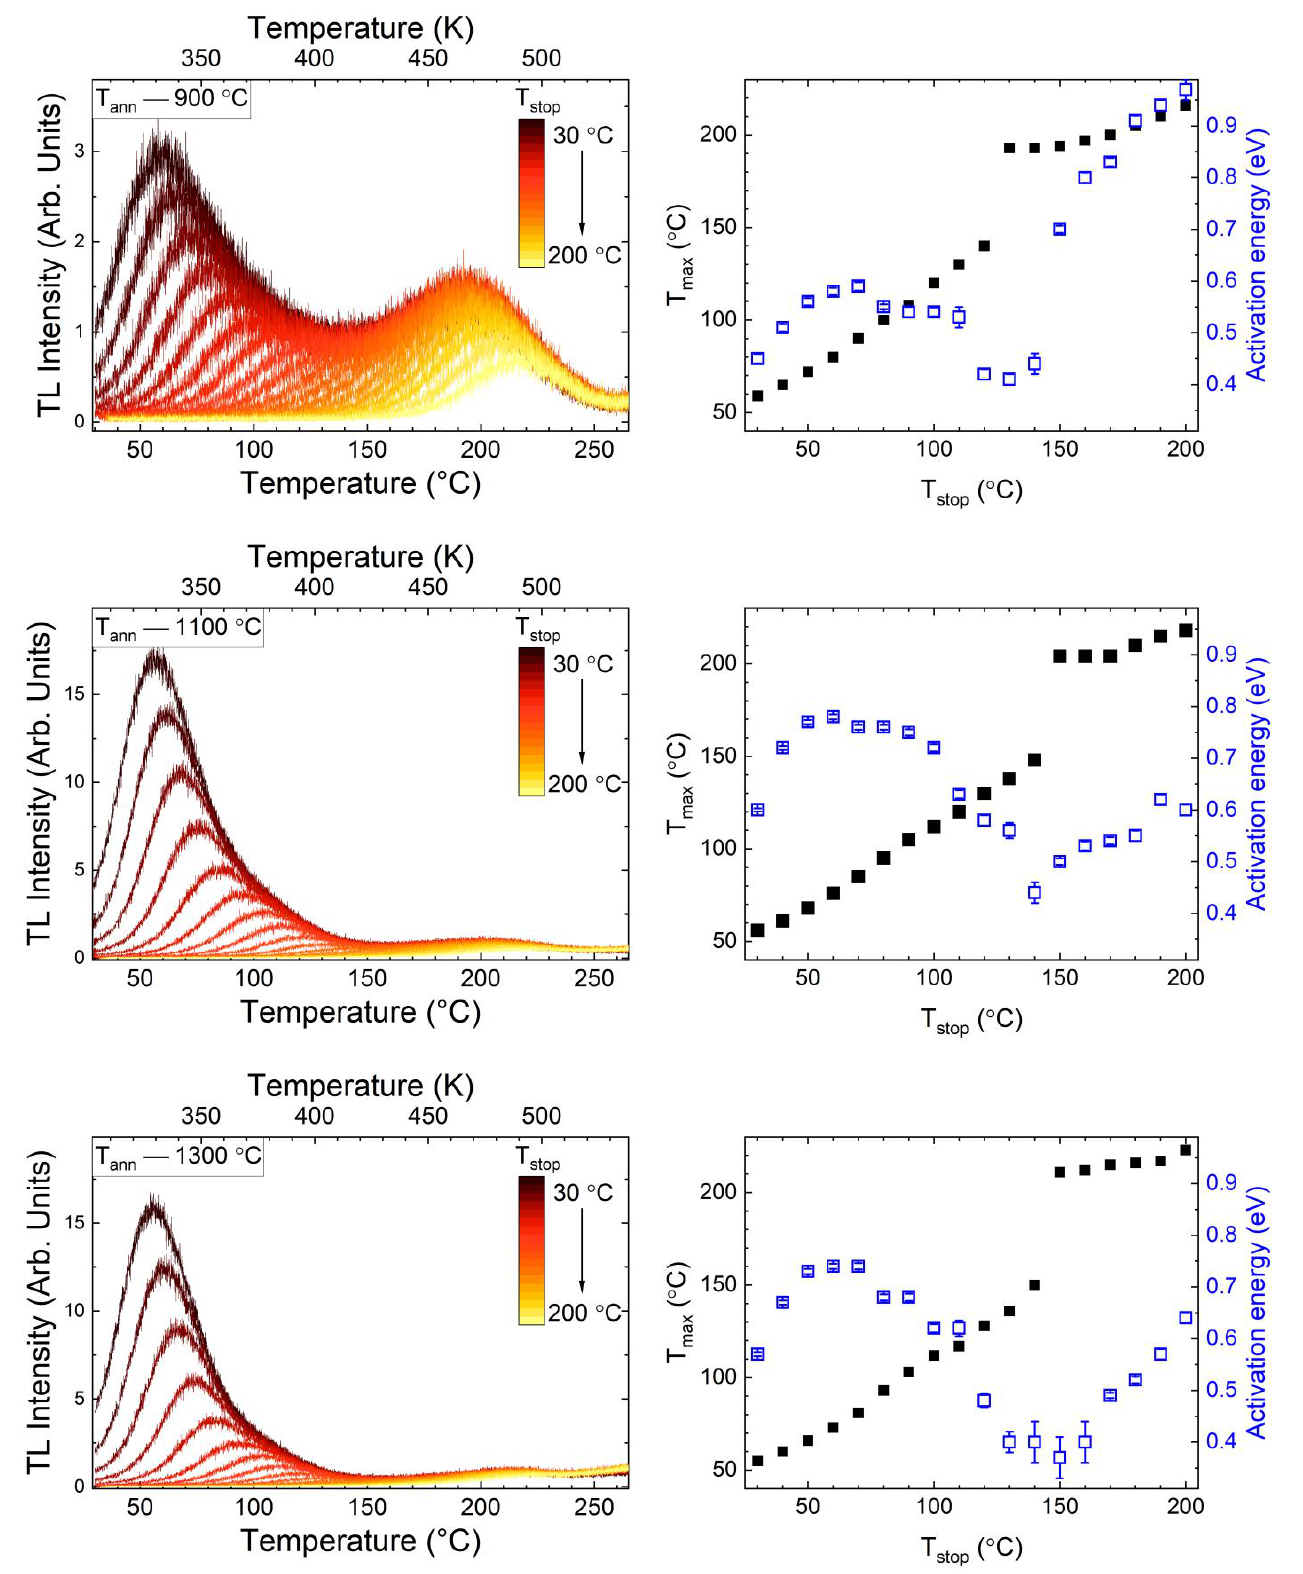
Figure 8. TL glow curves were detected with the T max -T stop methods and their analysis using the Initial-Rise method (blue points in the right row of panels). Samples were charged with X-rays for 5 min, β —0.5 ◦